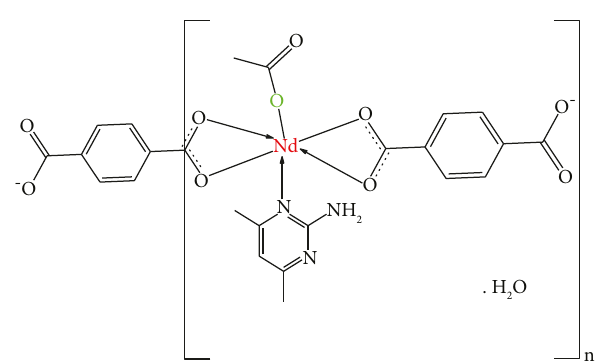
Figure 5: Suggesting structure of Nd(III) coordination